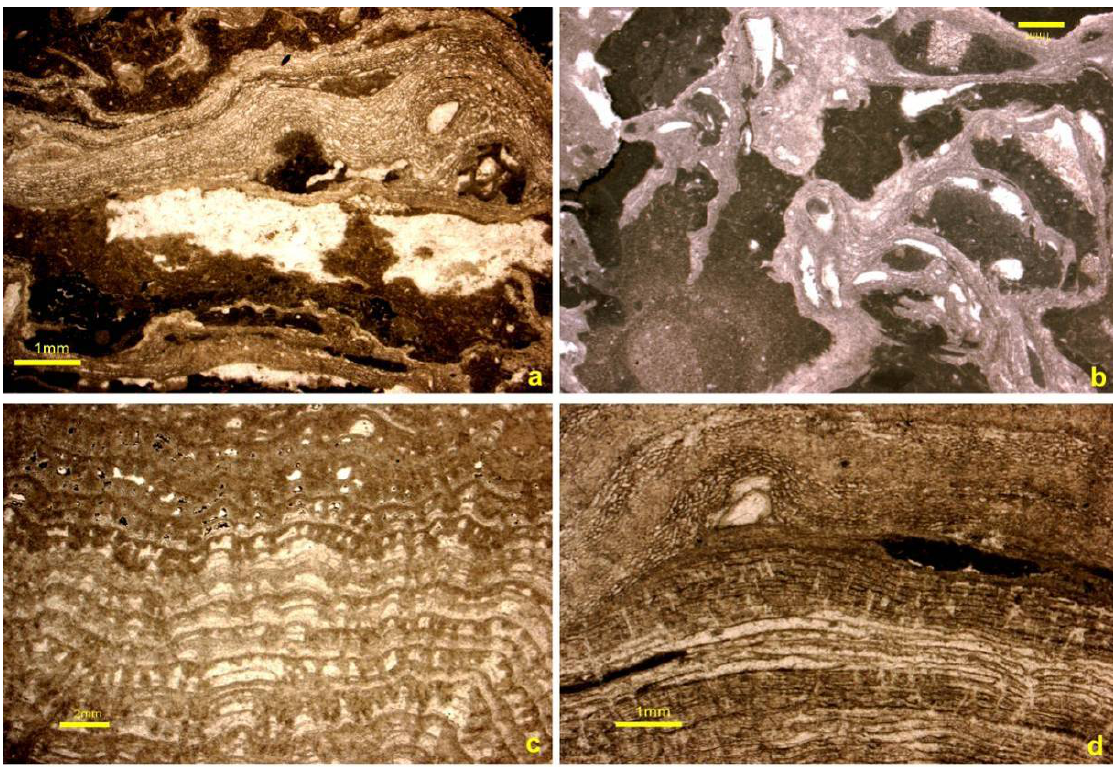
Figure 7. Dense reefal stromatoporoid and coral skeletons. ( a ) successive platy to weakly domal encrusting stromatoporoid Clathrodictyon lenticulare from middle to upper reef sequence capping sediment, encrusted by ‘spongiostromate’ crusts, making cavity space (GSC125412, locality A1489); ( b ) irregular growth of Clathrodictyon sinuosum with interstitial silty carbonate and calcimicrobial crusts, cavities, usually in basal reef portions (GSC128412, locality A1188); ( c ) dense skeleton of reef-adapted Tarphystroma found in reef tops and flanks (GSC127868, locality A1275); ( d ) biostromal occurrence of dense Forolinia , storm-disrupted, then settled by the heliolitid coral Propora ?, capped by Clathrodictyon (GSC127834, locality A1293); ( e ) intergrowth of the tabulate corals Catenipora (at base), Pycnolithus (middle and top) and Paleofavosites (above) from